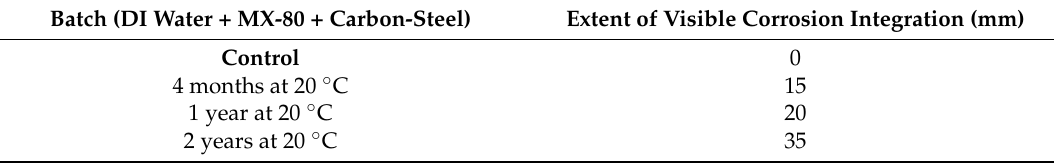
Figure 24. Plasticity index results comparison of duration vs. Carbon-steel/bentonite interface exposure at 20 °C, also includes one 150 °C result for comparison. Table 8. Plasticity index results comparison of duration vs. Carbon-steel/bentonite interface exposure at 20 °C with Deionised water.